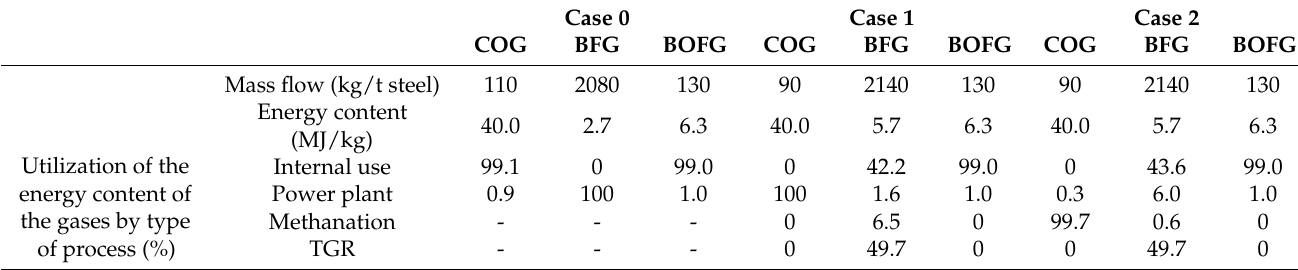
Table 4. Mass flow, energy content, and use of the fuel gases produced in the ironmaking